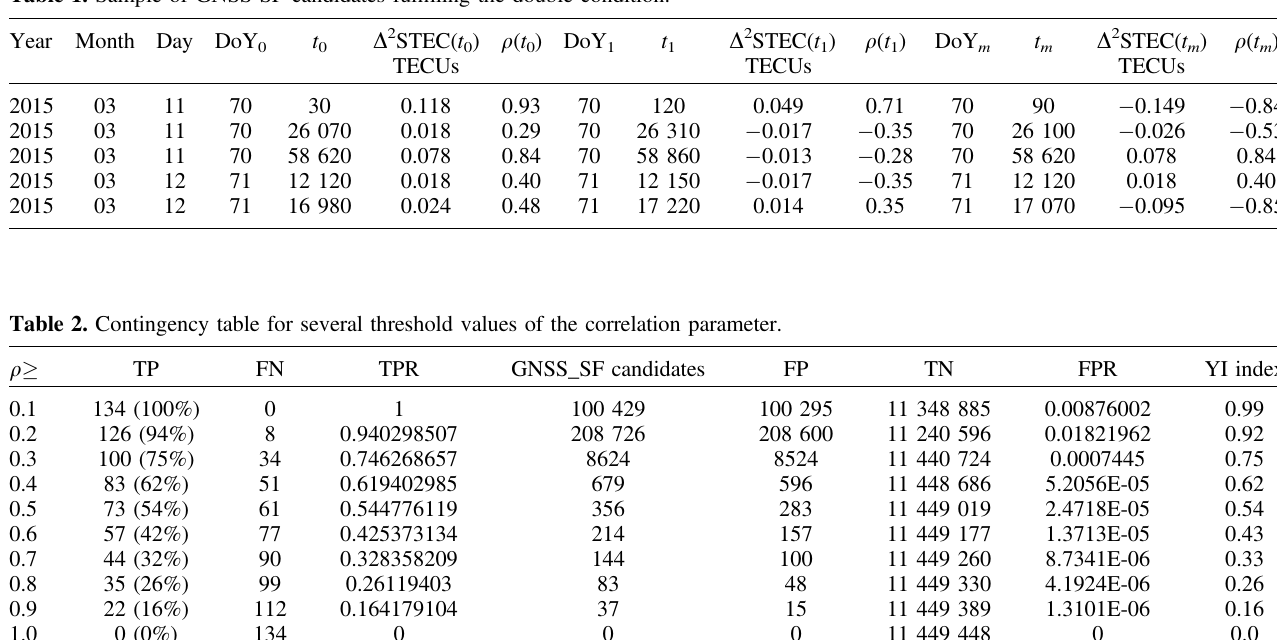
Table 1. Sample of GNSS-SF candidates ful fi lling the double condition.